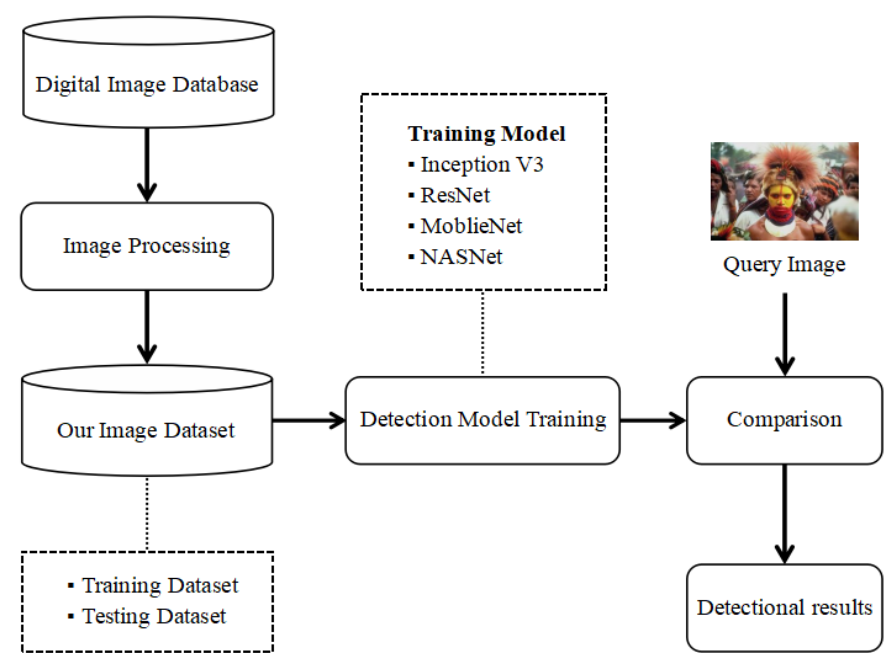
Figure 2. Flowchart of the proposed image copy detection scheme.